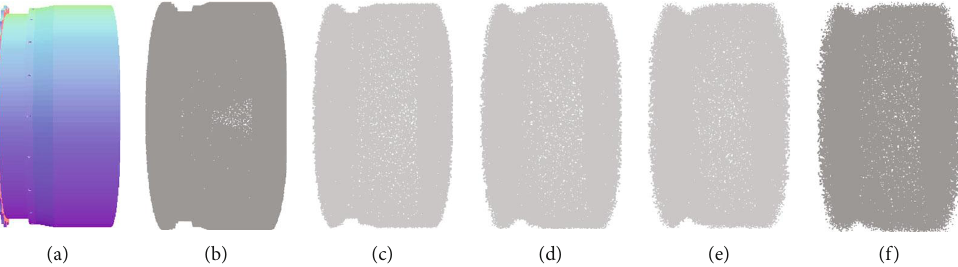
Figure 19: The original model and noisy point cloud involved in iterative denoising. (a) original triangle mesh. The point clouds with di ff erent noise scales (b) 0.0% b (c) 0.5% b (d) 1.0% b (e) 1.5% b (f)2.0% b.